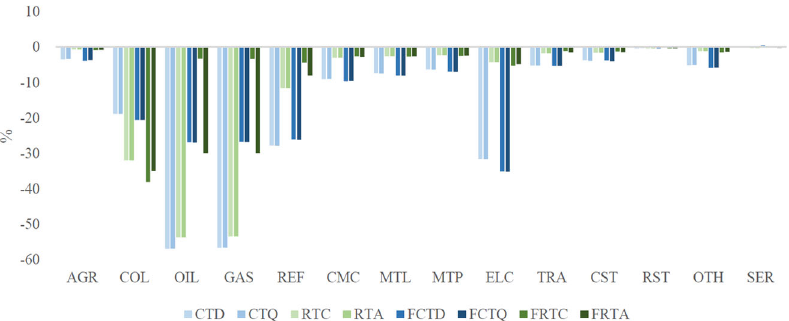
Fig. 5 Industrial Output changes in 2030. Blue bars are scenarios imposing carbon taxes, and green bars are scenarios imposing resource taxes. Deeper colors represent free market condition in these scenarios. Please refer to Table 2 for industry abbreviations.